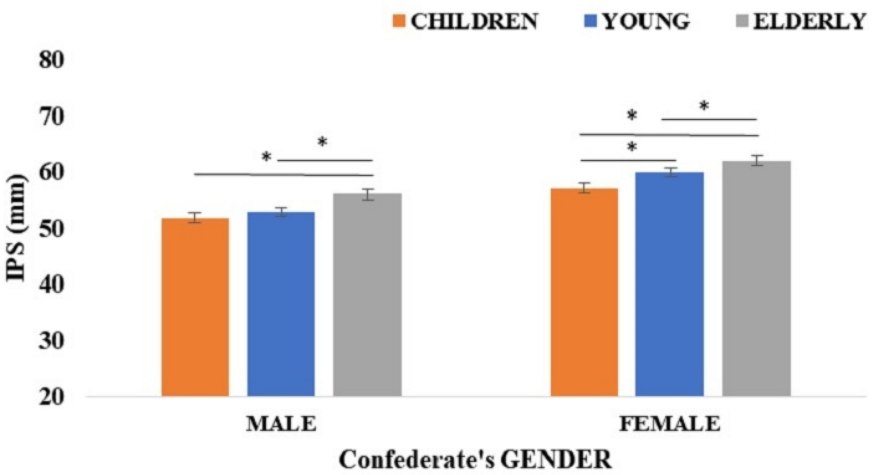
Figure 3. The figure shows the mean IPS (mm) as a function of male and female confederates of different ages (children, young and elderly people). The asterisk indicates a significant ( p < 0.05) difference between comparisons. Error bars depict standard error of the mean (SEM).